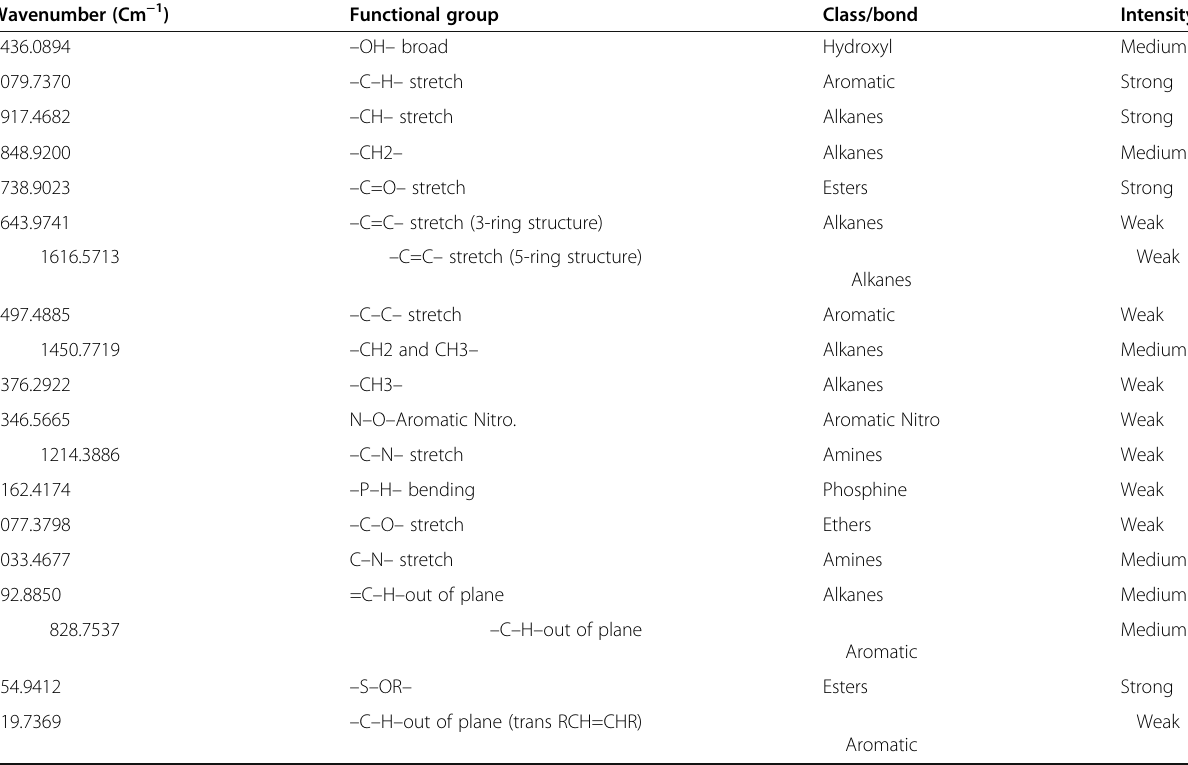
Table 2 FTIR analysis of anti-malarial active extract of Andrographis